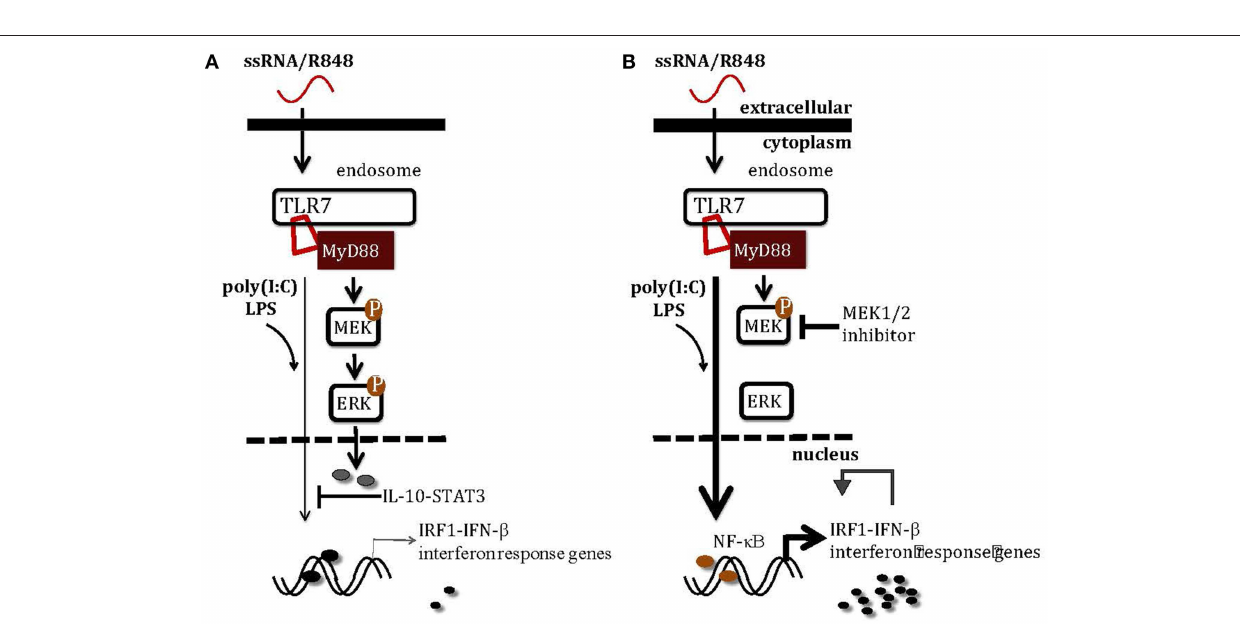
FIGURE 8 | A schematic illustration of how MEK1/2 pathway modulates the interferon responses in macrophages. (A) TLR3 activation by poly(I:C) and TLR4 activation by LPS induce scarce levels of Irf1 and interferon response genes, at least in part due to the inhibitory effects of MEK1/2-ERK-IL-10-STAT3 signaling. (B) Inhibition of MEK1/2 pathway using MEK1/2 inhibitor blocks activation of ERK-mediated inhibitory signaling, unlocking the IRF1-IFN- β -interferon signature response through the NF- κ B pathway. The combination therapy with TLR7 agonist and MEK1/2 inhibitor may greatly enhance the anti-tumor monotherapies with either TLR7 agonist or MEK1/2 inhibitor by boosting the interferon signature